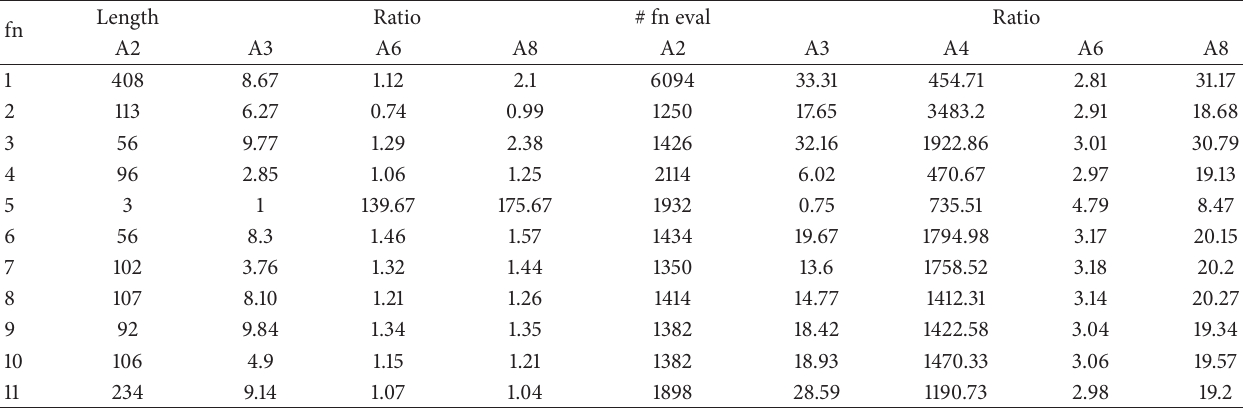
Table 7: The maximum list length from A2 and the ratio of the maximum list length from A3, A6, and A8 to the maximum list length from A2 when 𝑛 = 20 . Also the result of the total number of function evaluations ( 𝐹 and 𝑓 ).